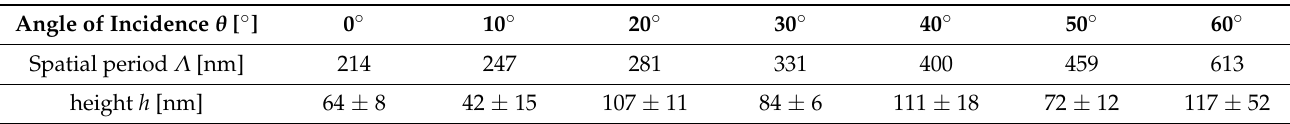
Table 1. Spatial period Λ , height of the ripples h ± standard deviations for LIPSS on PET formed with various angles of incidence θ of the laser beam ( Φ = 5.7–6.2 mJ/cm 2 , N = 6000 pulses). Angle of Incidence θ [ ◦ ] 0 ◦ Spatial period Λ